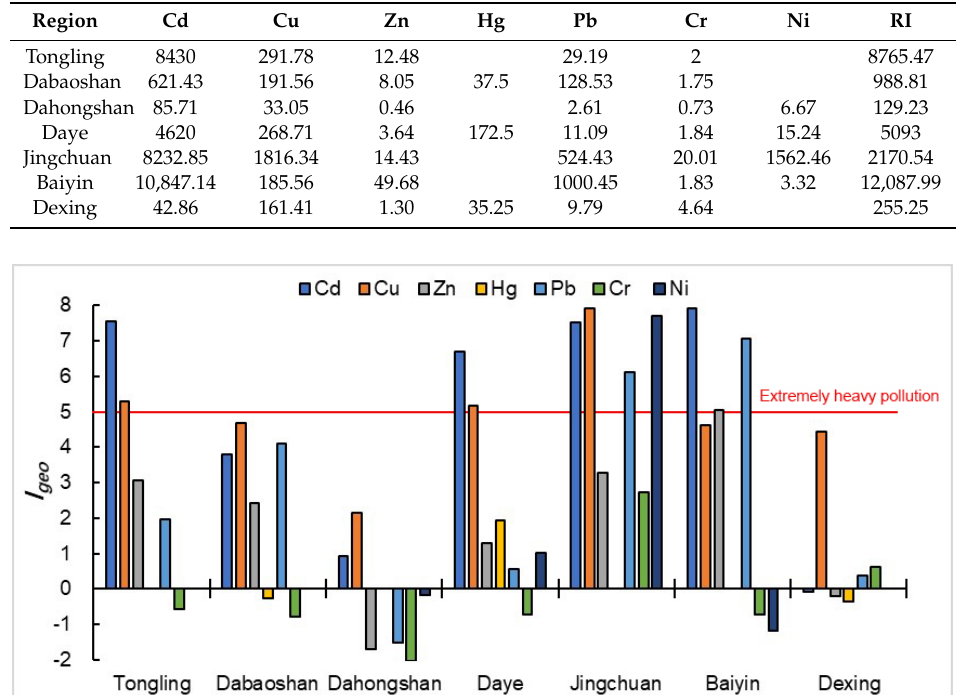
Table 4. Potential ecological risk index of sediments in rivers surrounding typical copper mines.